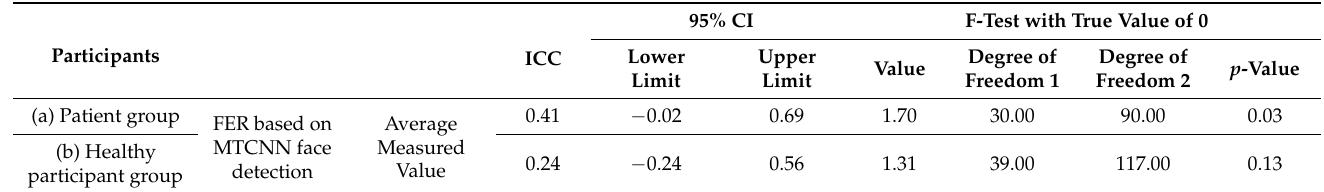
Table 4. Comparison of the means of the subjective FER from the three examiners and the FER based on MTCNN face detection’s ICC and 95% CI measurements in the patient and healthy partici- pant